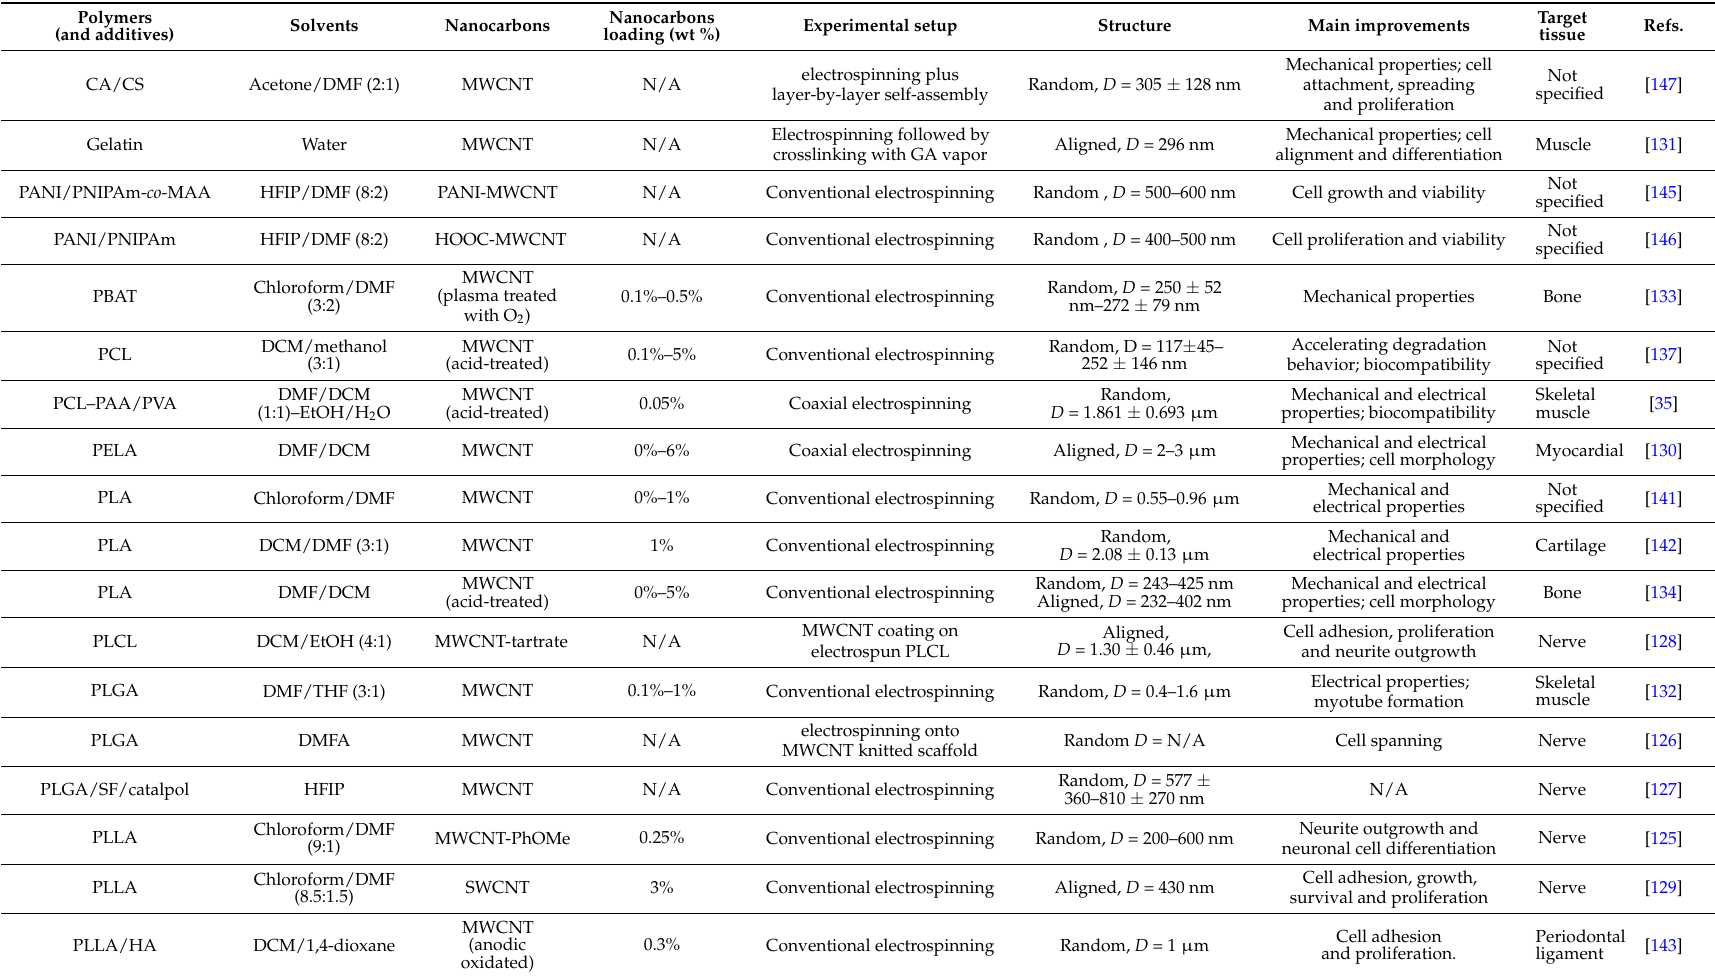
Table 2. Examples of polymer-CNTs electrospun scaffolds for tissue